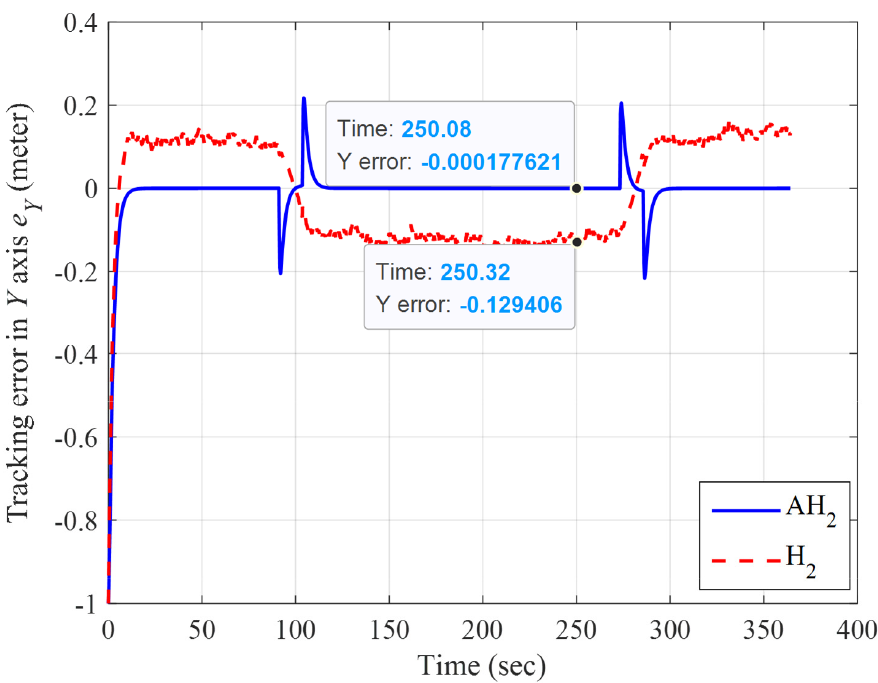
Figure 12. The square trajectory tracking error result of the adaptive H 2 closed-form and H 2 closed- form control approach for the y- axis from x p = − 7 m, y p = − 7 m.